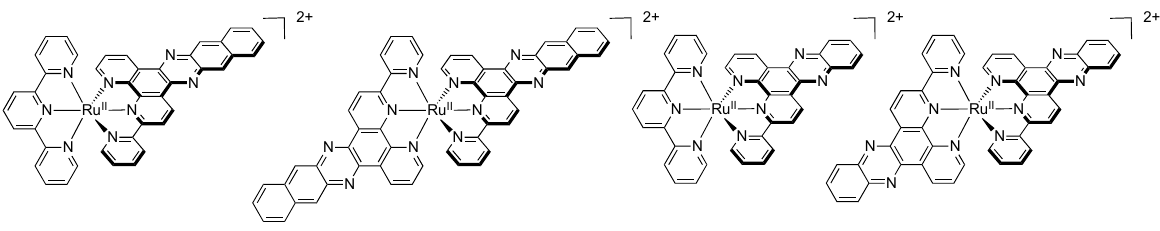
Figure 12. [Ru(TAP)